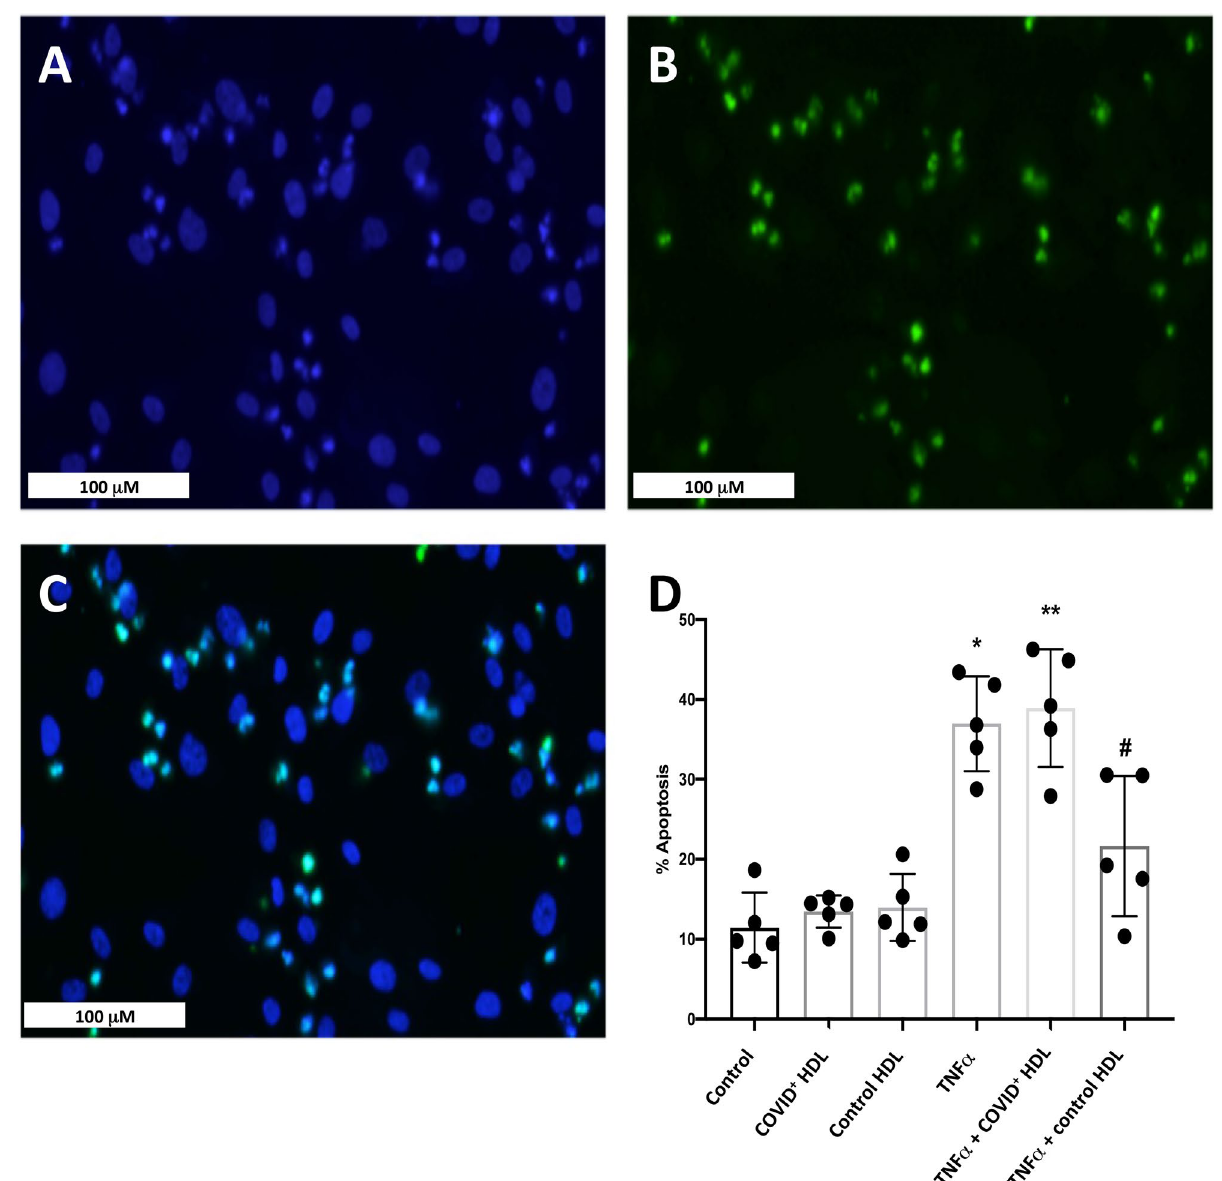
Figure 6. TUNEL and DAPI staining- Quantification of apoptotic nuclei. In TNFα-treated HUVECs (30 ng/ mL 24 h), dual staining shows a good correlation between morphological apoptotic features determined by nuclear condensation and fragmentation (DAPI in blue, A, C) and DNA fragmentation (green, B, C). Bar graph (D) represents the means ± SD of apoptotic nuclei count in 5 fields (between 700 and 900 nuclei counted) of a representative experiment. * p = 0.0332 (Control vs TNFα). **p = 0.002 (Control vs TNFα + COVID+ HDL). #p = 0.03 (TNFα + control HDL vs TNFα + COVID+